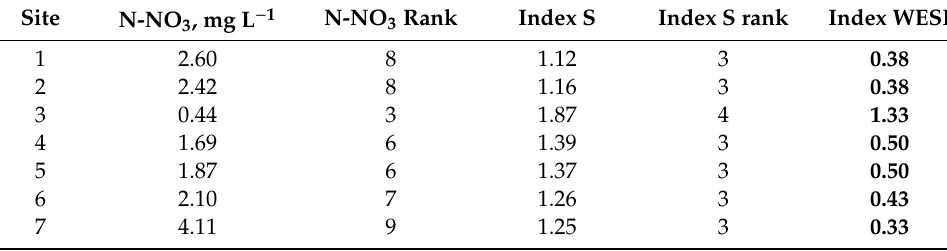
Table 7. Classification ranks of nitrate-nitrogen concentration and index saprobity S over sites of the Abraham Lincoln Birthplace National Historical Park for calculation of the water ecosystem state index (WESI). The abbreviations for the sites are the same as in Tables 1 and 2. Good ecosystem condition is marked by bold black font. A ff ected ecosystem condition is marked by bold red